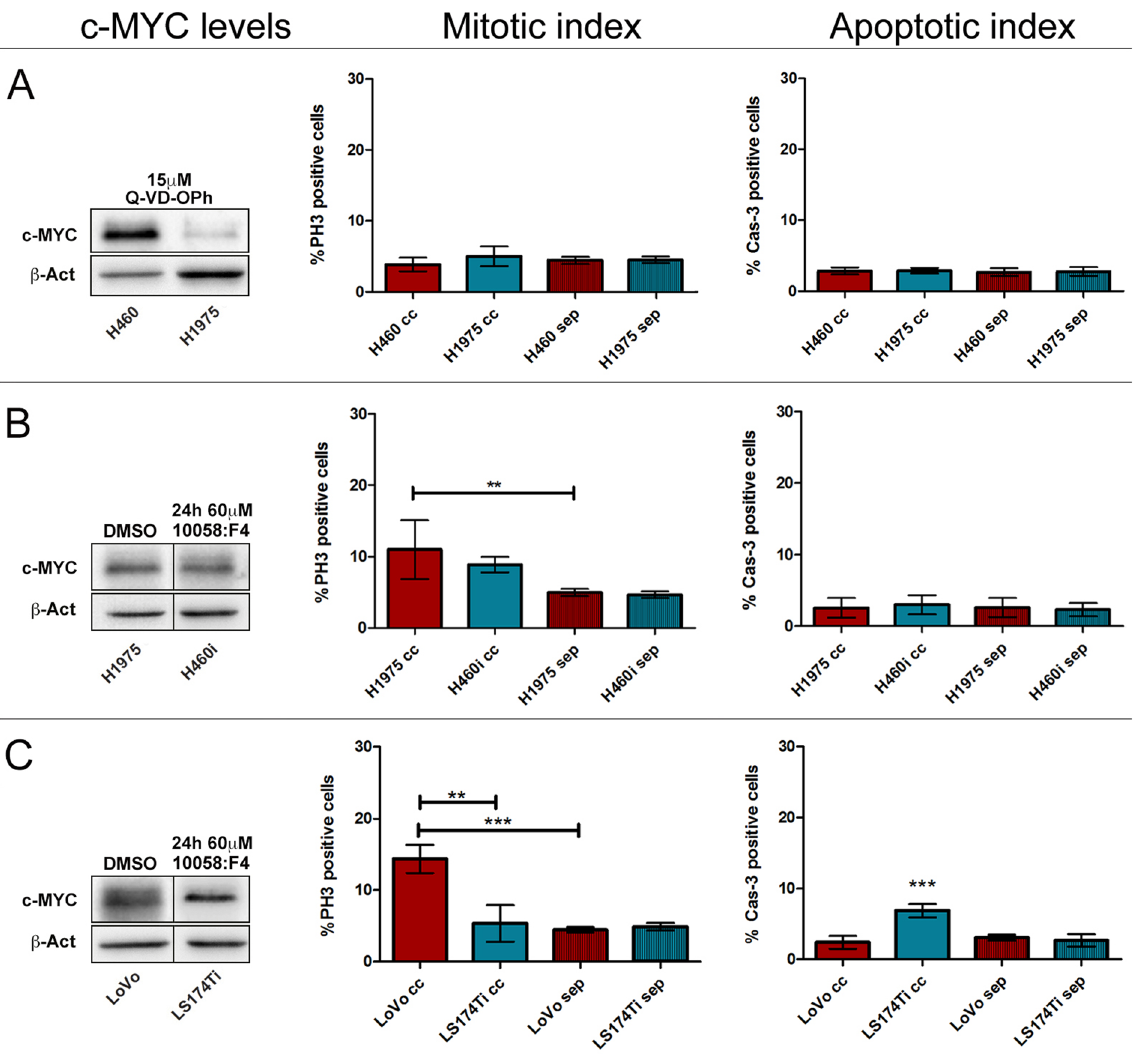
Figure 7. Apoptosis and MYC inhibition are both sufficient to impair the competitive ability of human cancer cell lines. ( A ) H460 vs H1975 lung cancer cell lines treated with the pan-caspase inhibitor Q-VD-OPh. ( B ) H1975 vs H460i (inhibited) lung cancer cell lines. ( C ) LoVo vs LS174Ti (inhibited) colon cancer cell lines. In each assay, the Western Blotting shows c-MYC protein levels of the two cell lines used and β -actin as a loading control (crops are indicated by black lines, the original blots can be found in Supplementary Fig. S7), with treatments indicated at the top of the lanes; the Mitotic Index shows the percentage of PH3-positive cells in the two lines after 5 h in co-culture (cc) or separate (sep) conditions; the Apoptotic Index is represented as the percentage of Cas3-positive cells at the end of the assay. Statistical significance and ± SD are